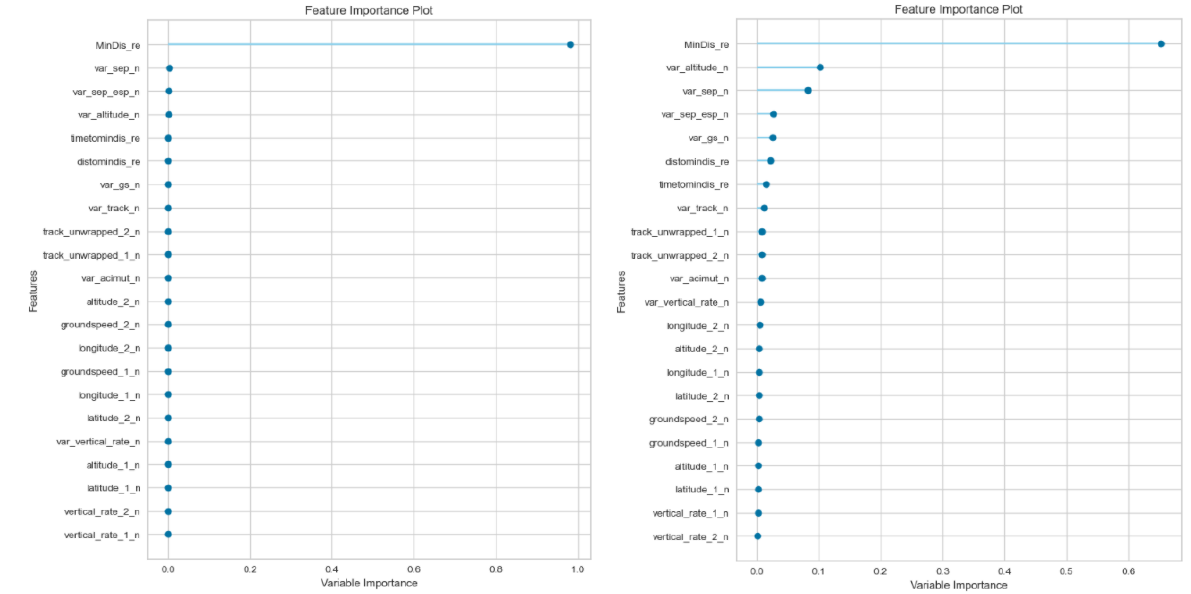
Figure 7. Feature importance of the Pure model (left) and the Hybrid model (right) for regression. The next step is to optimise the Extreme Gradient algorithm. Only the optimisation of RMSE was studied. Table 4 shows the results of both experiments on the training set applying a fivefold cross-validation. Table 4. Results (NM) of the regression experiments. Table 4. Results (NM) of the regression experiments. Experiment